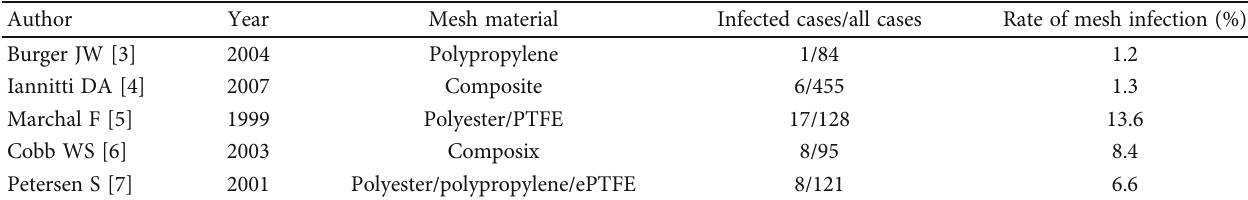
Figure 4: Postoperative cystography and computed tomography (CT) scan. Cystography of the neobladder showed no leakage (a). Subcutaneous fl uid collection is observed on postoperative day 14 (b). It improved by postoperative day 29 (c). Table 1: Previous reports on infections of mesh used for abdominal incisional hernias.